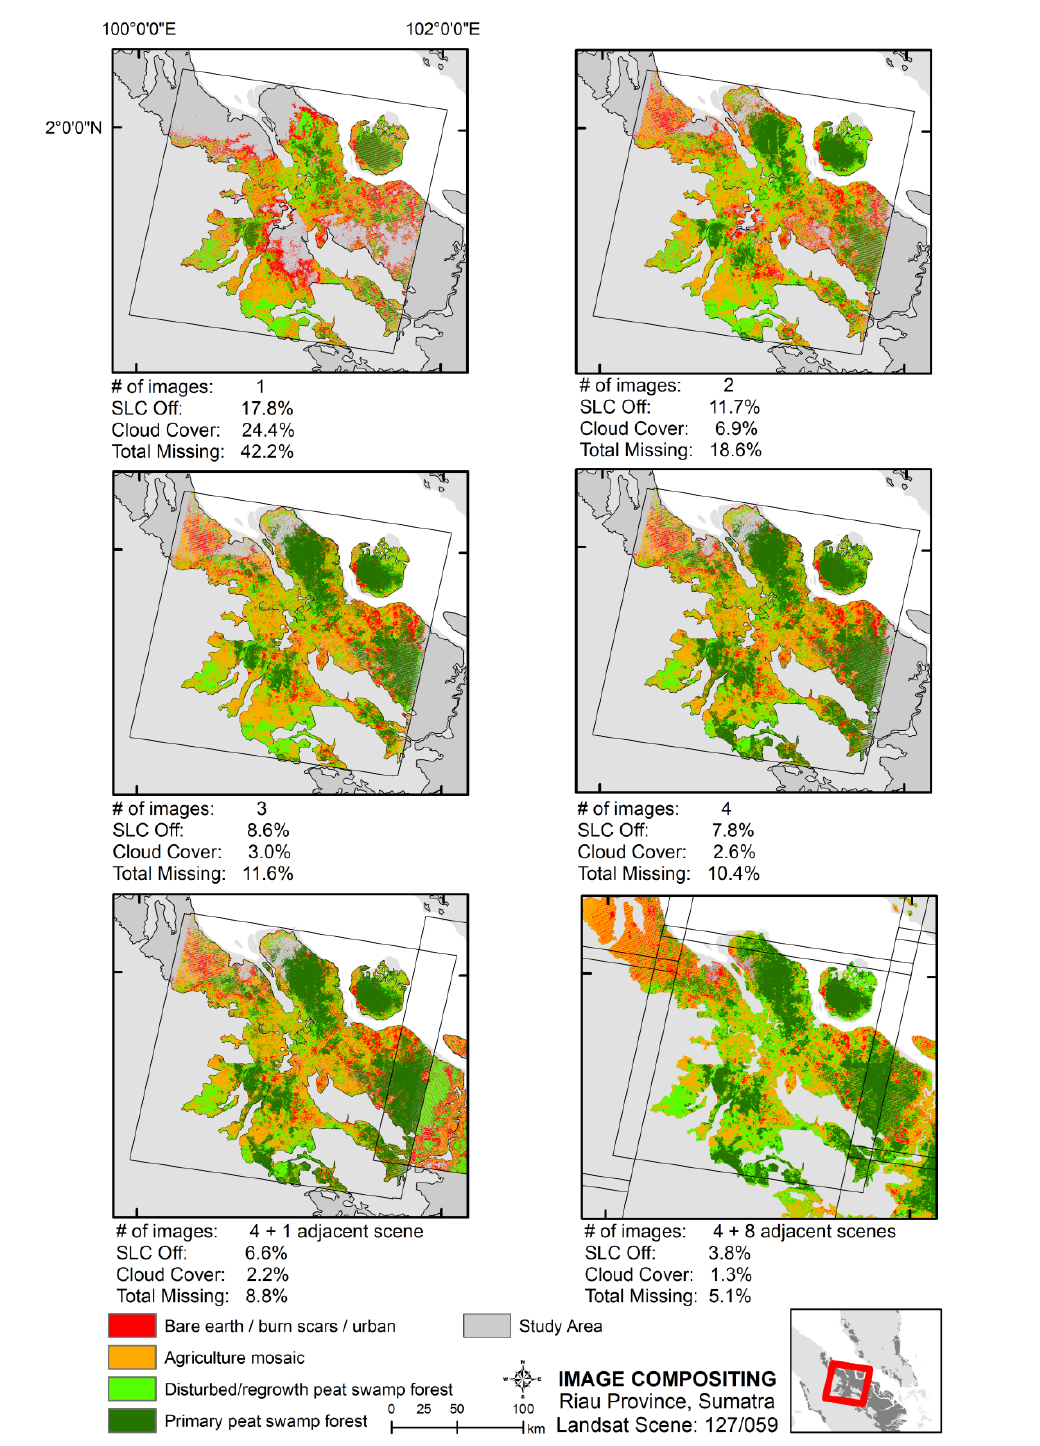
Figure 8. Spatial illustration of missing-data reduction per image when compositing four Landsat-7 SLC-Off images for scene 127/059 of the 2010 composite mosaic. Percentages reported are with respect to the study area, not the entire scene. The mapped area